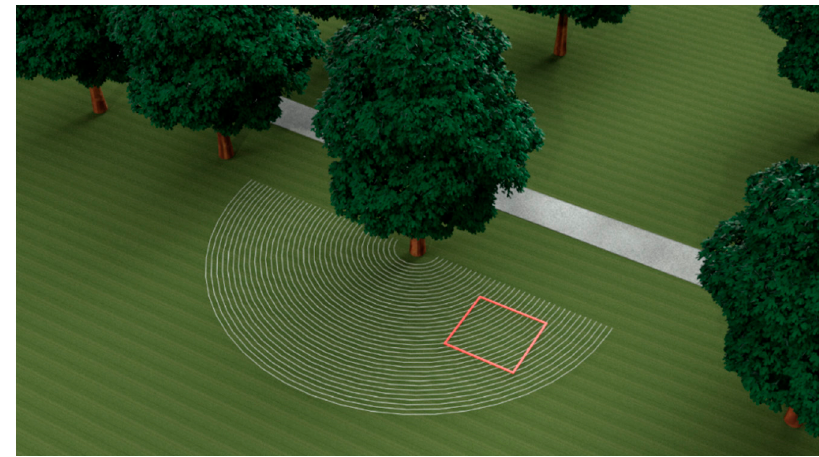
Figure 16. Rendering of the surveyed area, showing the position of the excavated site.